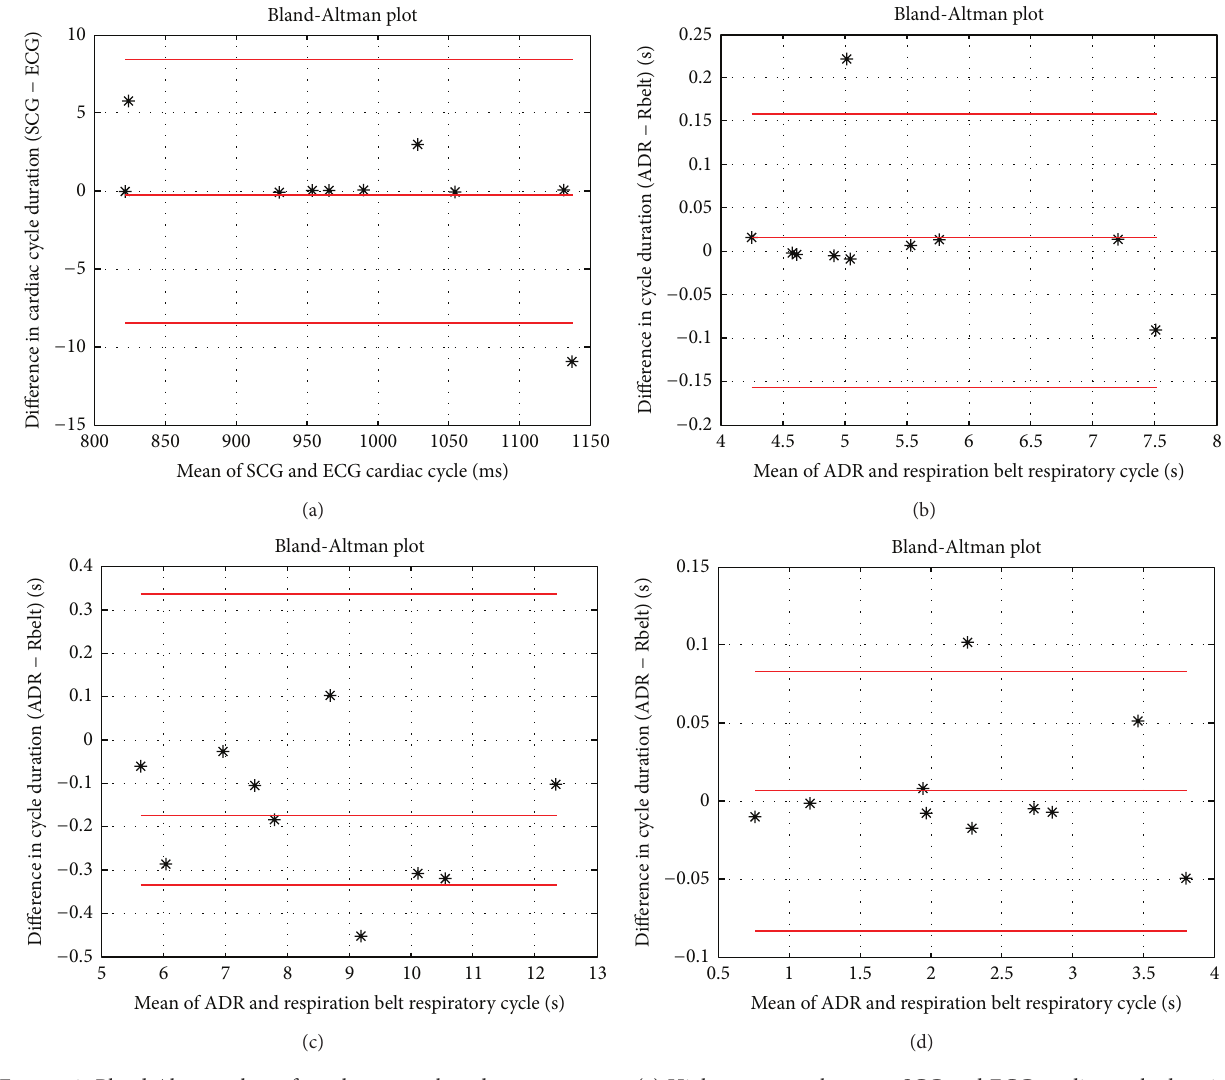
Figure 9: Bland-Altman plots of accelerometer-based measurements. (a) High agreement between SCG and ECG cardiac cycle duration. ((b), (c), and (d)) Good agreement of the respiratory cycle duration across normal, slow-paced, and fast-paced breathing, respectively.